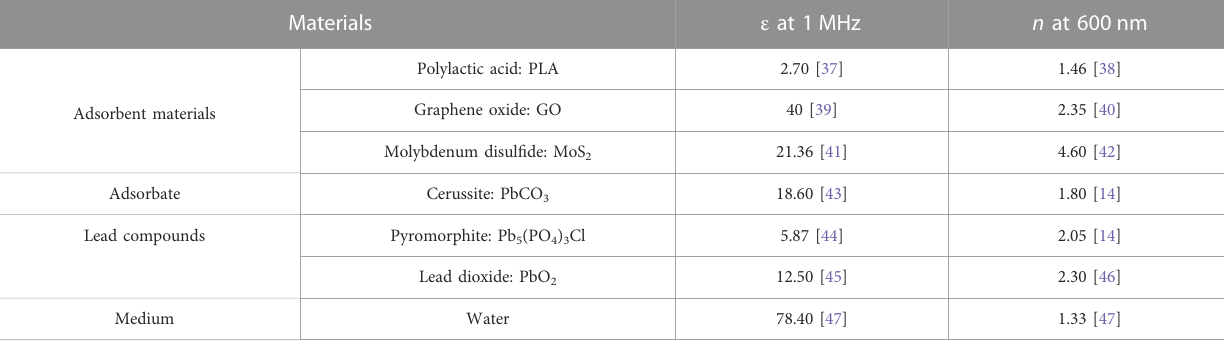
TABLE2Dielectricconstantsandrefractiveindexesofadsorbent(PLA,GO,andMoS 2 )andlead-insolubleadsorbate “ PbCO 3 ,Pb 5 (PO 4 ) 3 Cl,PbO 2 ” andwateratroom temperature (298 K). Materials